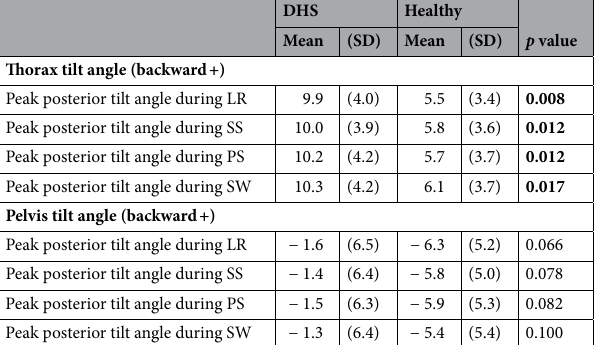
Table 3. Comparison of thorax and pelvis angles during walking between the two groups. Bold figures indicate statistically significant p < 0.05. Unit is degree. DHS Dropped head syndrome, LR loading response, SS single stance, PS pre-swing, SW